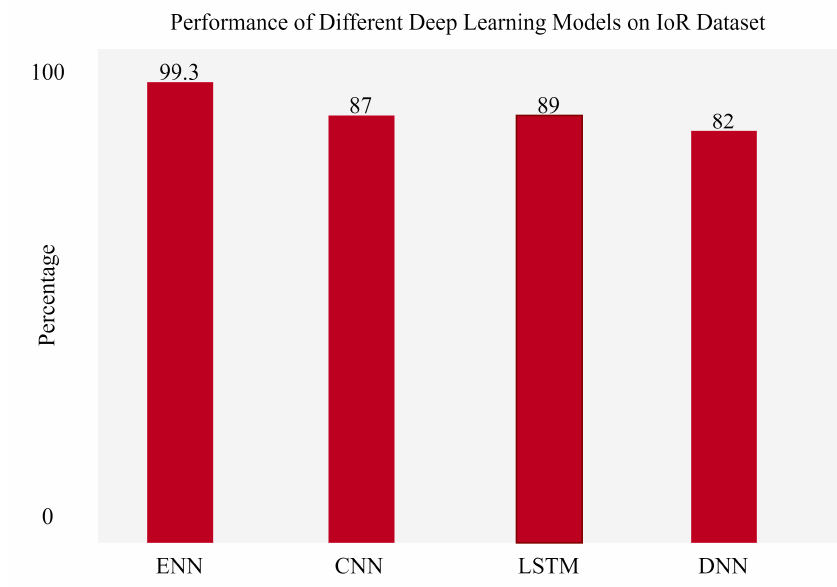
Figure 12. Accuracy of Deep Learning Models on Dataset 2.